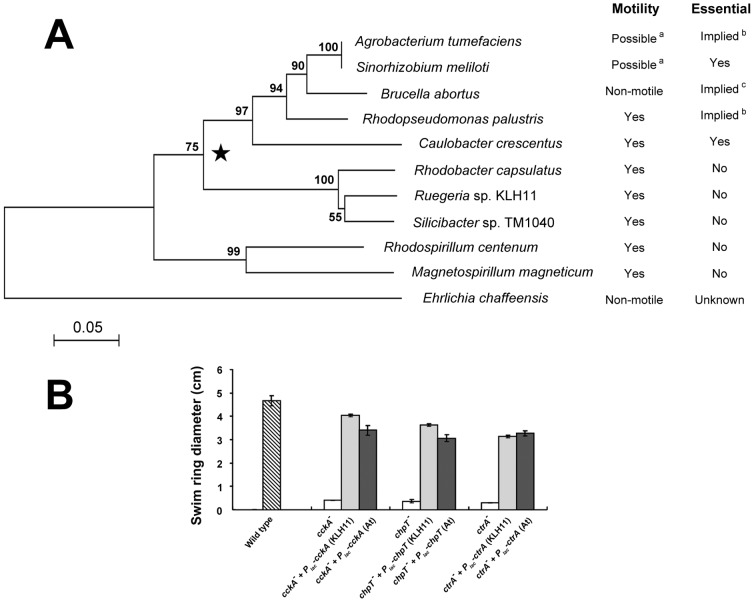
Phylogeny of the CtrA protein cross-complementation between KLH11 and A. tumefaciens.
A) Phylogenetic analyses of CtrA from members of alpha-
Proteobacteria
. CtrA sequences from bacterial species in which CtrA has been studied were chosen for phylogenetic anaylsis. The sequences used were A. tumefaciens C58 (GenBank Accession No. NP_355385), B. abortus (AAL86376), C. crescentus (NP_421829), E. chaffeensis (YP_507798), Magnetospirillum magneticum AMB-1 (YP_419992), Rhodopseudomonas palustris (NP_946978), Rhodobacter capsulatus (AAF13177), Rhodospirillum centenum (YP_002297962), Ruegeria sp. KLH11 (ZP_05124475), Silicibacter sp. TM1040 (YP_613394) and Sinorhizobium meliloti (NP_386824). The star indicates the divergence between organisms in which CtrA is essential or implied to be essential and in which CtrA does affect viability, which was originally proposed by Green et al. [37] a = motility-related genes are enriched in putative CtrA binding sites ([12]; b = unable to obtain a ctrA deletion mutant without providing an extra copy of the ctrA gene (J.E. Heindl and C. Fuqua, unpublished) [36]; c = gene target (ccrM) of CtrA is essential [50]. The scale bar indicates the number of amino acid substitutions per site. B) Cross complementation of motility between KLH11 and
A. tumefaciens
 homologues. Wild-type KLH11 (EC1) and derivatives were inoculated on MB2216 (supplemented with 0.25% agar) swim agar plates for about 8 days at 28°C. 200 µM IPTG was added to the media. The diameter of the swim ring was measured. Parentheses indicate from which species the relevant homologue is used (At stands for A. tumefaciens). Values are averages of assays performed in triplicate and error bars are standard deviations.